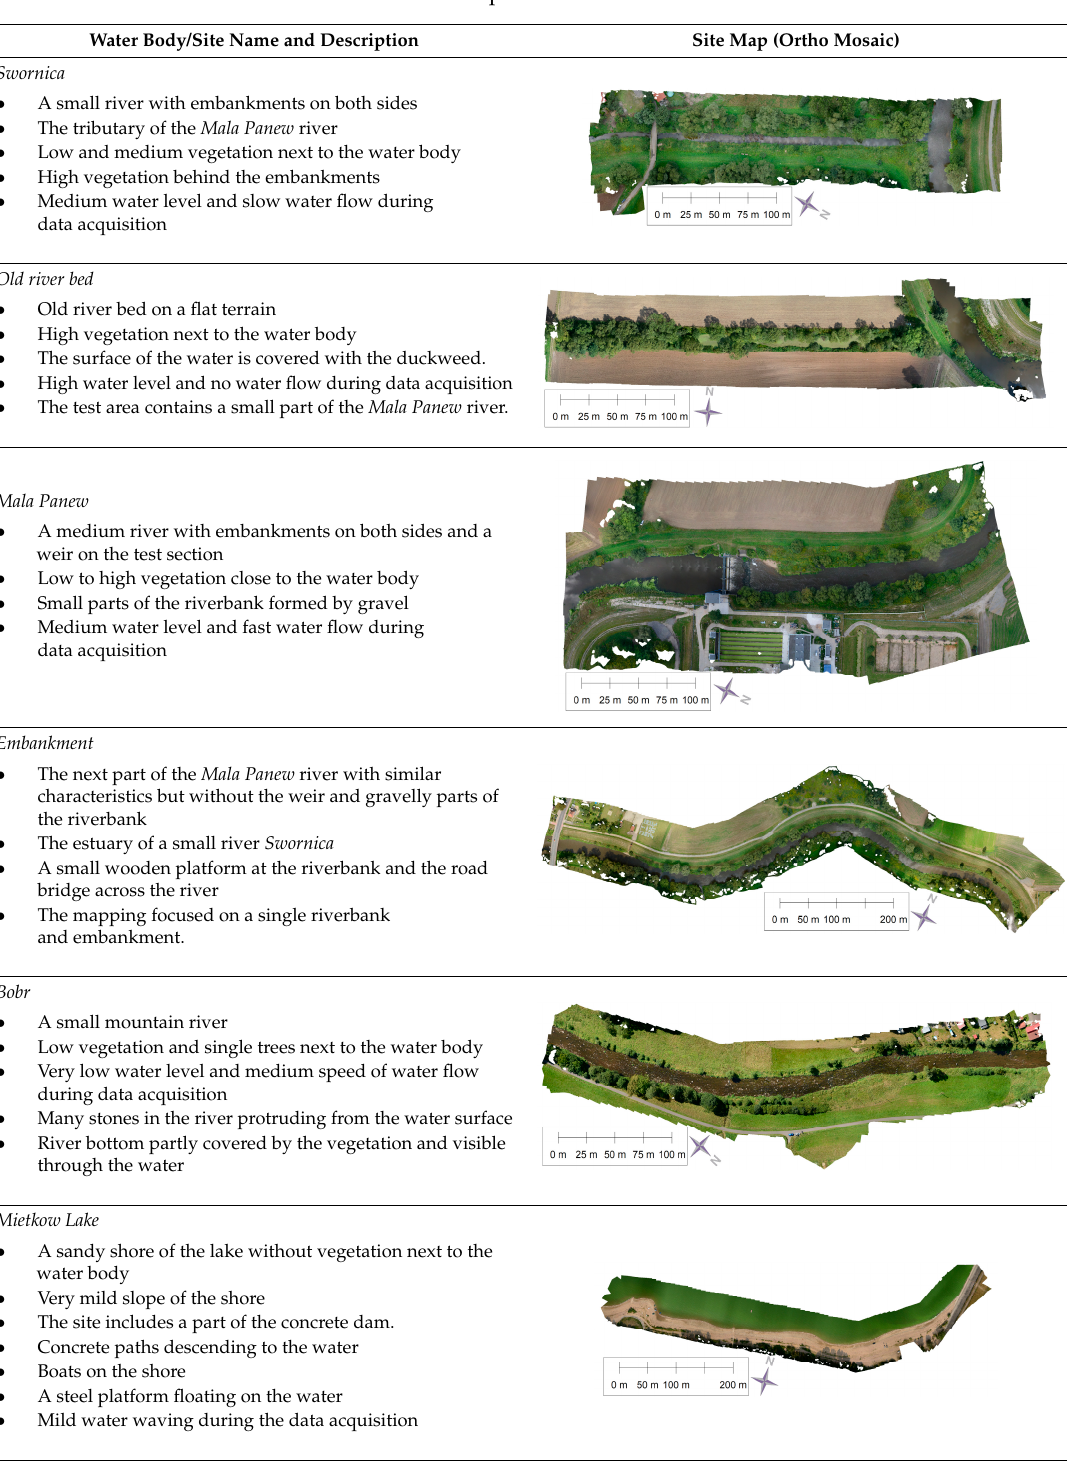
Table 1. Descriptions of the test